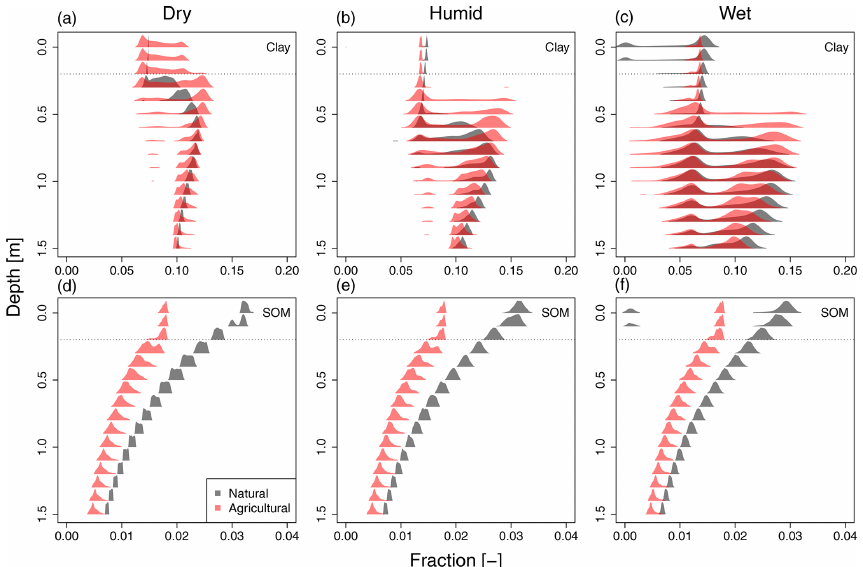
Figure 4. Probability density functions (PDFs) showing the multi-modal distributions of soil properties throughout the catchment per 10cm depth increment. We only show probabilities larger than 5% for clarity. The presented soil properties are clay fraction (a, b, c) and SOM fraction (d, e, f) , for the different rainfall scenarios (columns). Grey colors represent the natural soils, while red colors represent agricultural soils. The horizontal dotted line indicates the ploughing depth used for simulations (20cm).